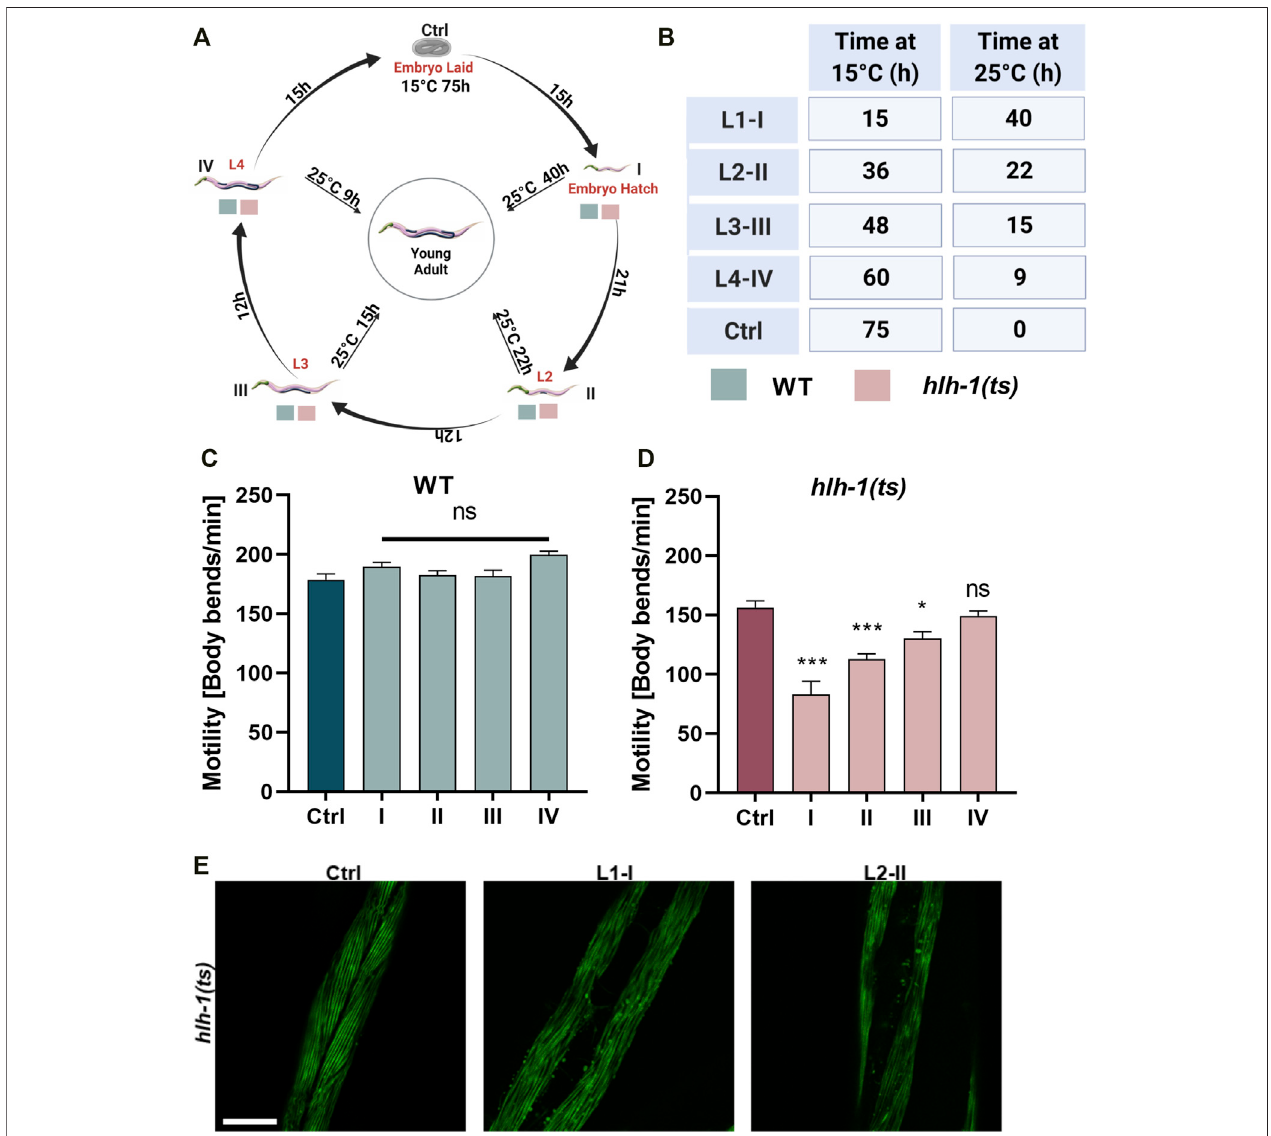
FIGURE 1 | Differentiation transcription factor HLH-1 is required for muscle maintenance during larval development. (A) Schematic representation of the experimentalsetup.Wild type (WT)or hlh-1(ts) embryoswereplacedonseededplates at15 ° C.Animalsweremaintainedat 15 ° C(Ctrl) orshifted to25 ° Cattheindicated times,correspondingtospeci fi clarvalstages(L1-I,L2-II,L3-III,andL4-IV).Youngadults(YA,beforetheonsetofegg-laying)werethenanalyzed formotility,myo fi lament organization, and chaperone expression. (B) A list of treatments duration (in hours) at 15 ° C and 25 ° C for each group (Ctrl and I-IV). (C – D) Motility rates of temperature-shifted YA. Thrashing rates were scored on day one of adulthood for WT (C) or hlh-1(ts) (D) animals grown at 15 ° C for the duration of the experiment (Ctrl- 75 h)orshiftedto25 ° Cattheindicatedtimes(I-15h,II-36h,III-46 horIV-60 h).Dataaremeans±1standarderrorofthemean(1SE). Datawereanalyzedusingone-way ANOVA followed by a Dunnett ’ s post-hoc test (N = 3, n = 30). (*) denotes p < 0.05, (**) denotes p < 0.01, (***) denotes p < 0.001, and (ns) denotes p > 0.05, compared with Ctrl animals maintain at 15 ° C. (E) Representative images of age-synchronized hlh-1(ts) animals that express MYO-3::GFP. Animals were grown at 15 ° C for